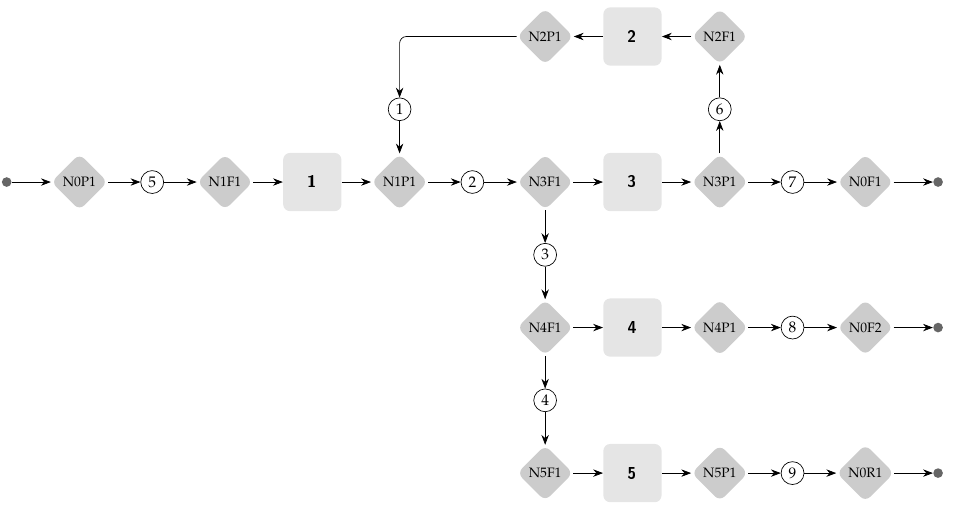
Figure 3. Productive structure graph of TGAS